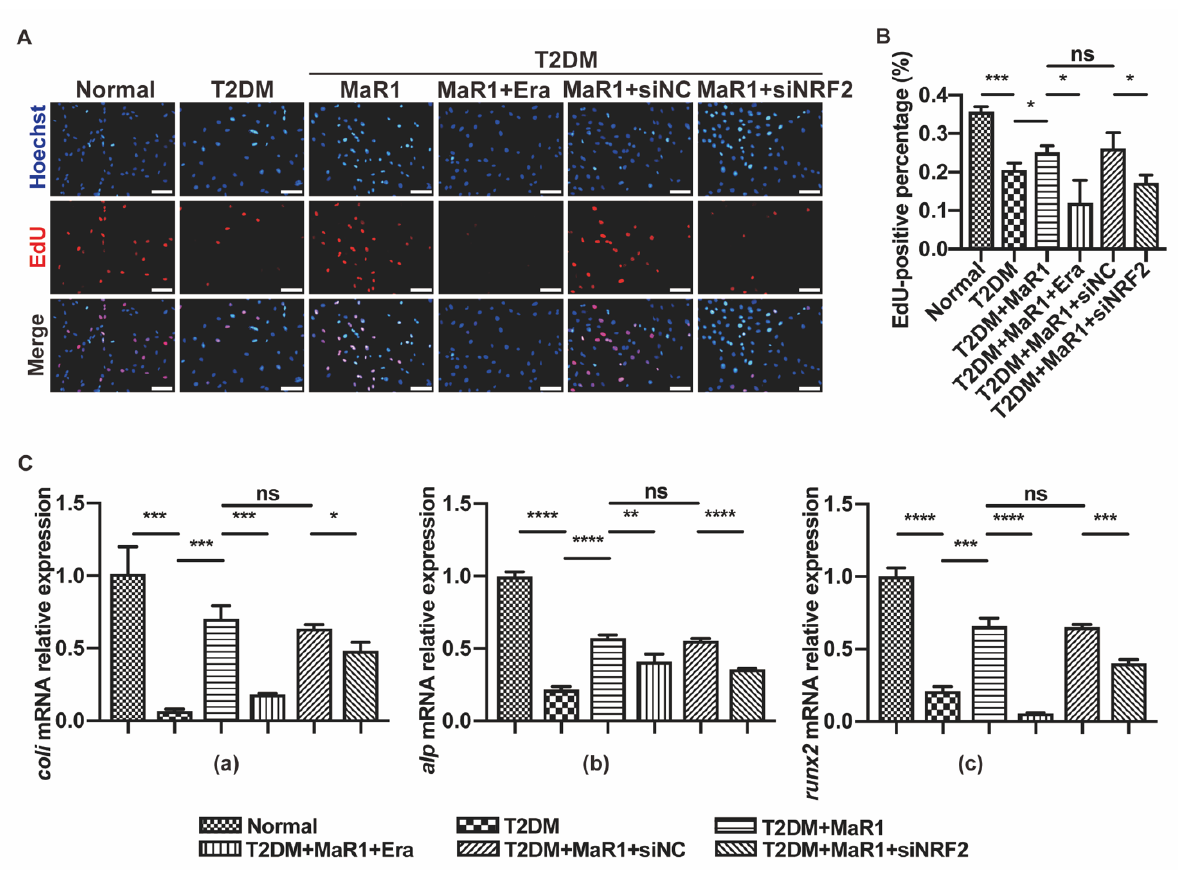
Figure 4. MaR1 protects from ferroptosis-mediated impairment of osteogenic differentiation of osteoblasts by modulating NRF2 signaling in T2DOP. ( A ) EdU staining was used to assess cell survival. Red, EdU-positive nuclei; blue, all nuclei. Scale bar = 100 µ m. ( B ) EdU-positive cell quantification analysis. ( C ) The mRNA expressions of Coli , Alp, and Runx2 were detected using quantitative real-time polymerase chain reaction (qRT-PCR). Data are presented as means ± SDs from three separate experiments (n = 3). ns p > 0.05; * p < 0.05; ** p < 0.01; *** p < 0.001; **** p < 0.0001. SiNC: siRNA negative control; siNRF2: siRNA of